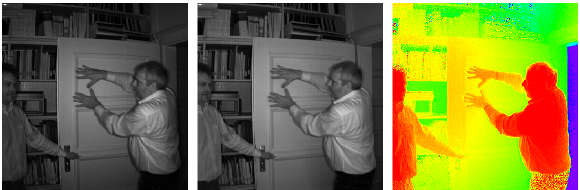
Figure 2: Visualization of the data captured with a PMD[vision] CamCube 2.0: Normalized active intensity, normalized passive intensity and range data (from left to right). The range increases from red pixels via yellow and green pixels to blue pixels.